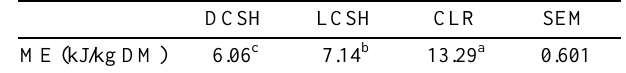
Table 2. Metabolisable energy (ME) of delinted cottonseed hulls (DCSH), linted cottonseed hulls (LCSH) and cottonseed linter residue (CLR) estimated by in vitro ruminal gas production and chemical composition DCSH